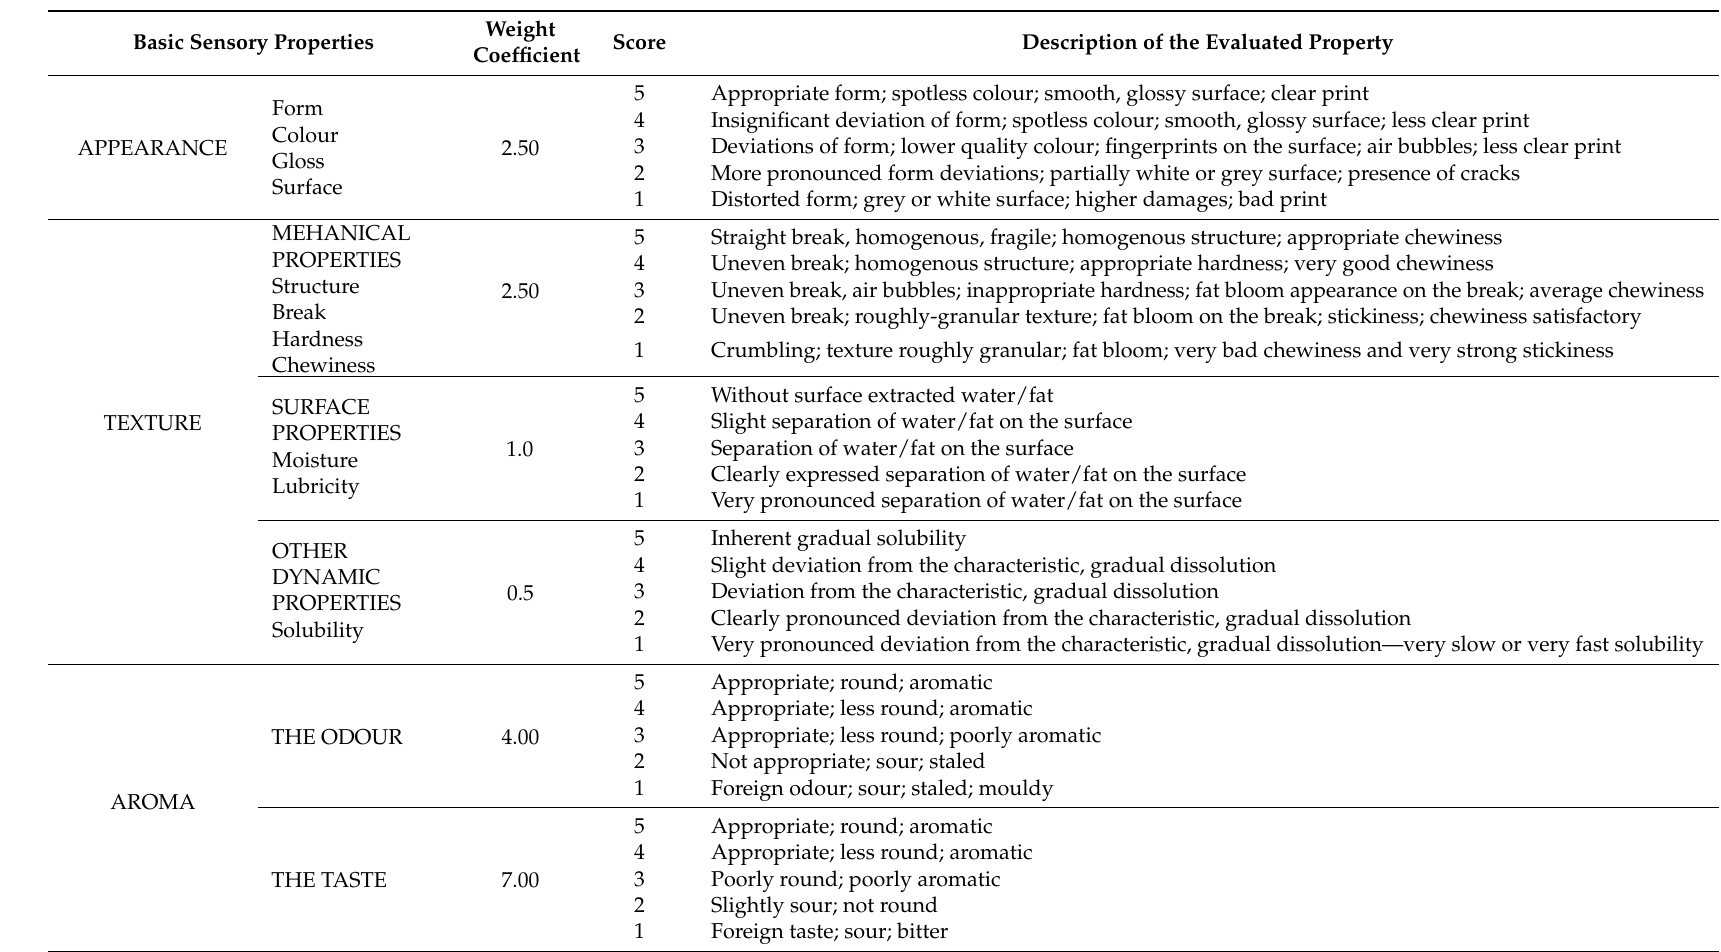
Table 1. Sensory evaluation of dark